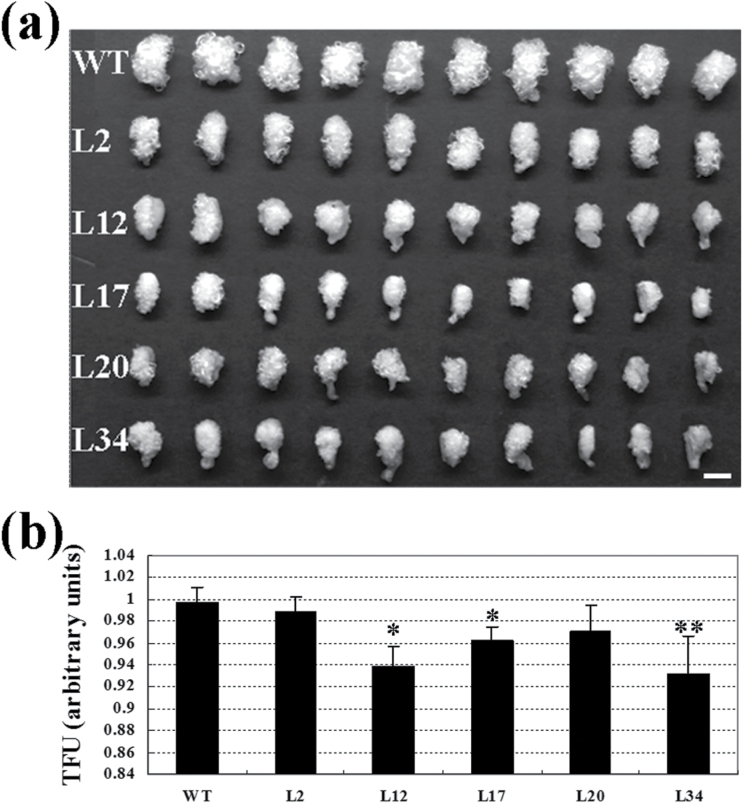
Total fibre unit (TFU) analysis of dominant repression-GhKNL1 transgenic cotton plants. Cotton ovules at 1 DPA were cultured in liquid BT medium at 30 °C in darkness for 20 days. (A) Comparison of the phenotype of in vitro cultured ovules with fibres in the wild type (WT) and transgenic lines (L2, L12, L17, L20, and L34). (B) Fibre surface area measured by dye binding in TFU of in vitro cultured ovules. Independent t-tests demonstrated that there were significant differences (*P<0.05) or very significant differences (**P<0.01) in TFU between transgenic plants and the wild type. Bar = 0.5mm.